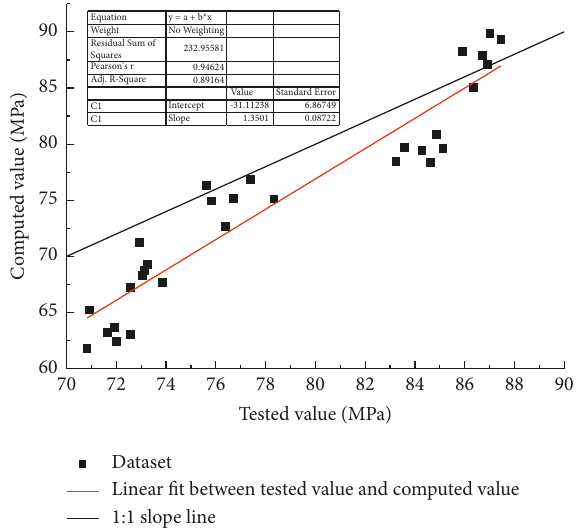
Figure 16: Cross-correlation of tested and computed values from damage variable on